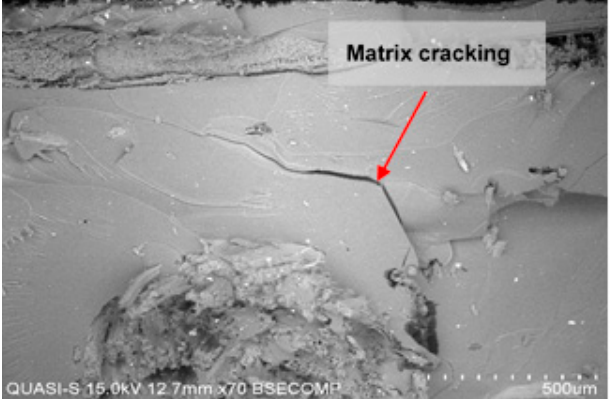
Figure 10. Matrix cracking is observed at resin rich area in 6 × 6 fabric.